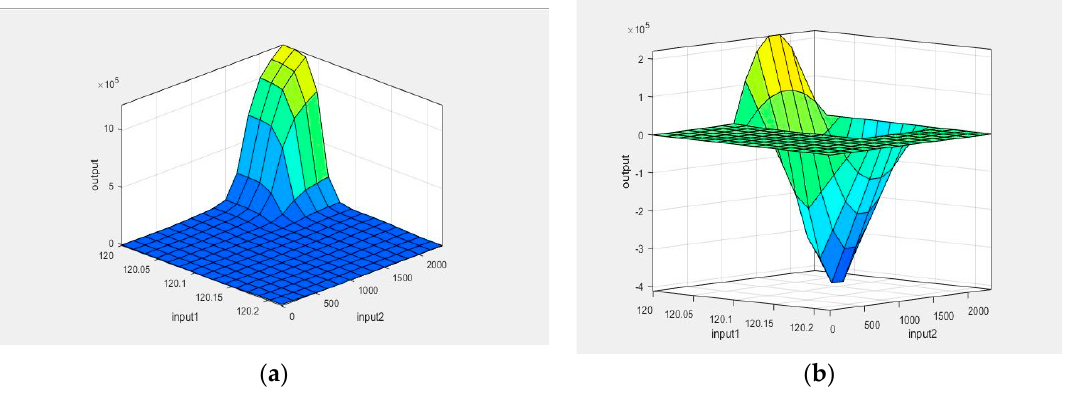
Figure 20. Surface plot. ( a ) P-F ANFIS; ( b ) Q-V ANFIS.